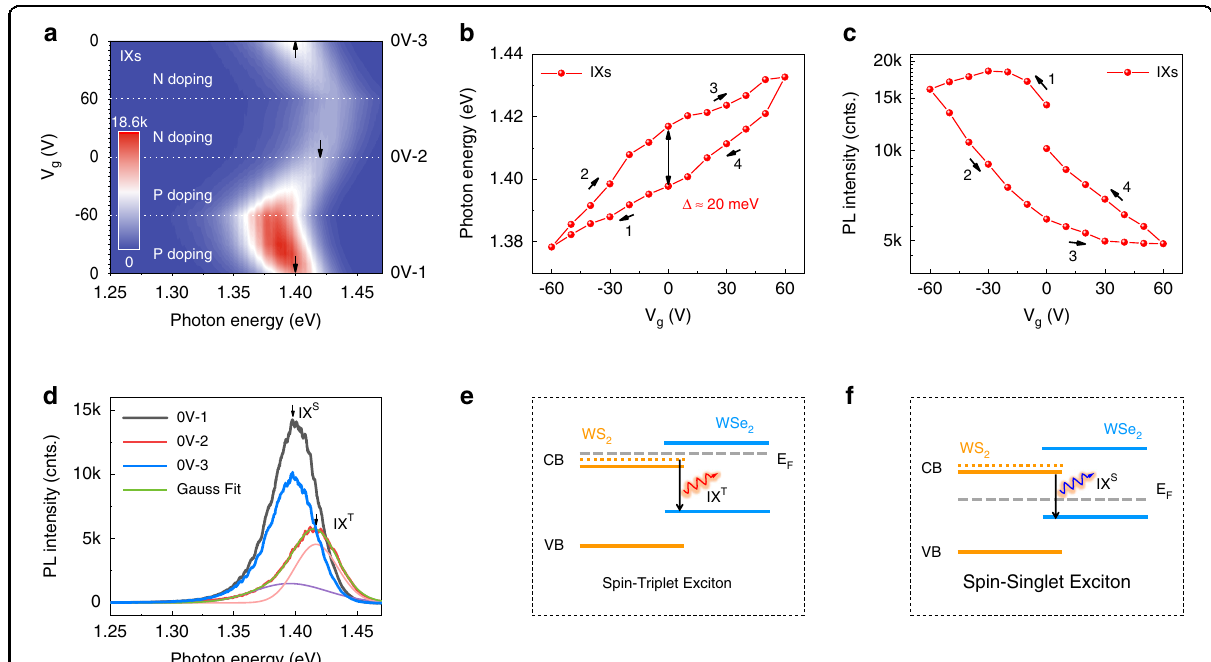
Fig. 2 Electrical control of the IX emission. a Contour plot for the PL spectra of IXs upon cyclic V g . The white dashed lines serve as guides to the eye. Black arrows mark the peak positions of the IXs at 0 V with different scanning sequences. b , c Photon energy and PL intensity of the IX emission as a function of V g . d PL spectra of the IXs at 0 V with different scanning sequences. 0V-1, 0V-2, and 0V-3 represent three spectra marked in a . The 0V-2 spectrum is fi tted by two Gaussian peaks. The purple and pink lines are attributed to the spin-singlet state (IX S ) and spin-triplet state (IX T ) of interlayer excitons, respectively. The sample was excited by a 532 nm laser with 23 μ W power at 78 K. e , f Schematic of the spin-triplet and spin-singlet excitons. Chemical-doped electrons lift the Fermi level up and shift the IX S to IX T . When those electrons are released, the IX T return to IX S . The orange dashed line stands for the upper spin-splitting conduction band (CB) of WS 2 . Red and blue arrows represent the recombination paths of the